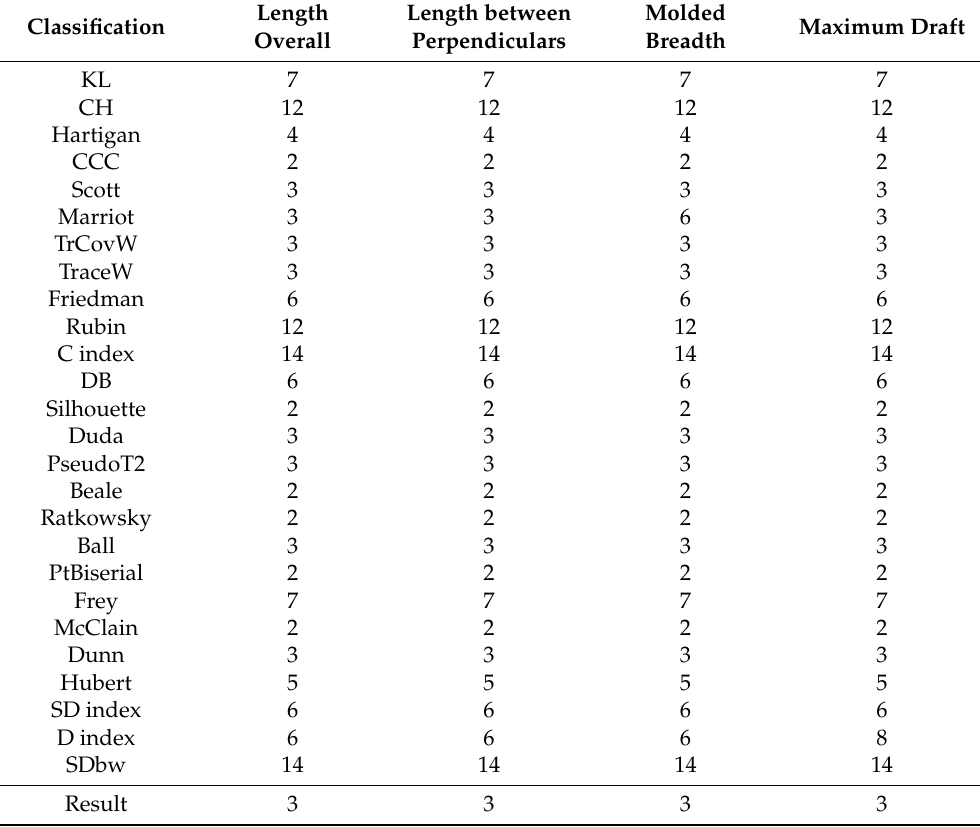
Table 4. Results of optimal value of k according to k -means clustering.